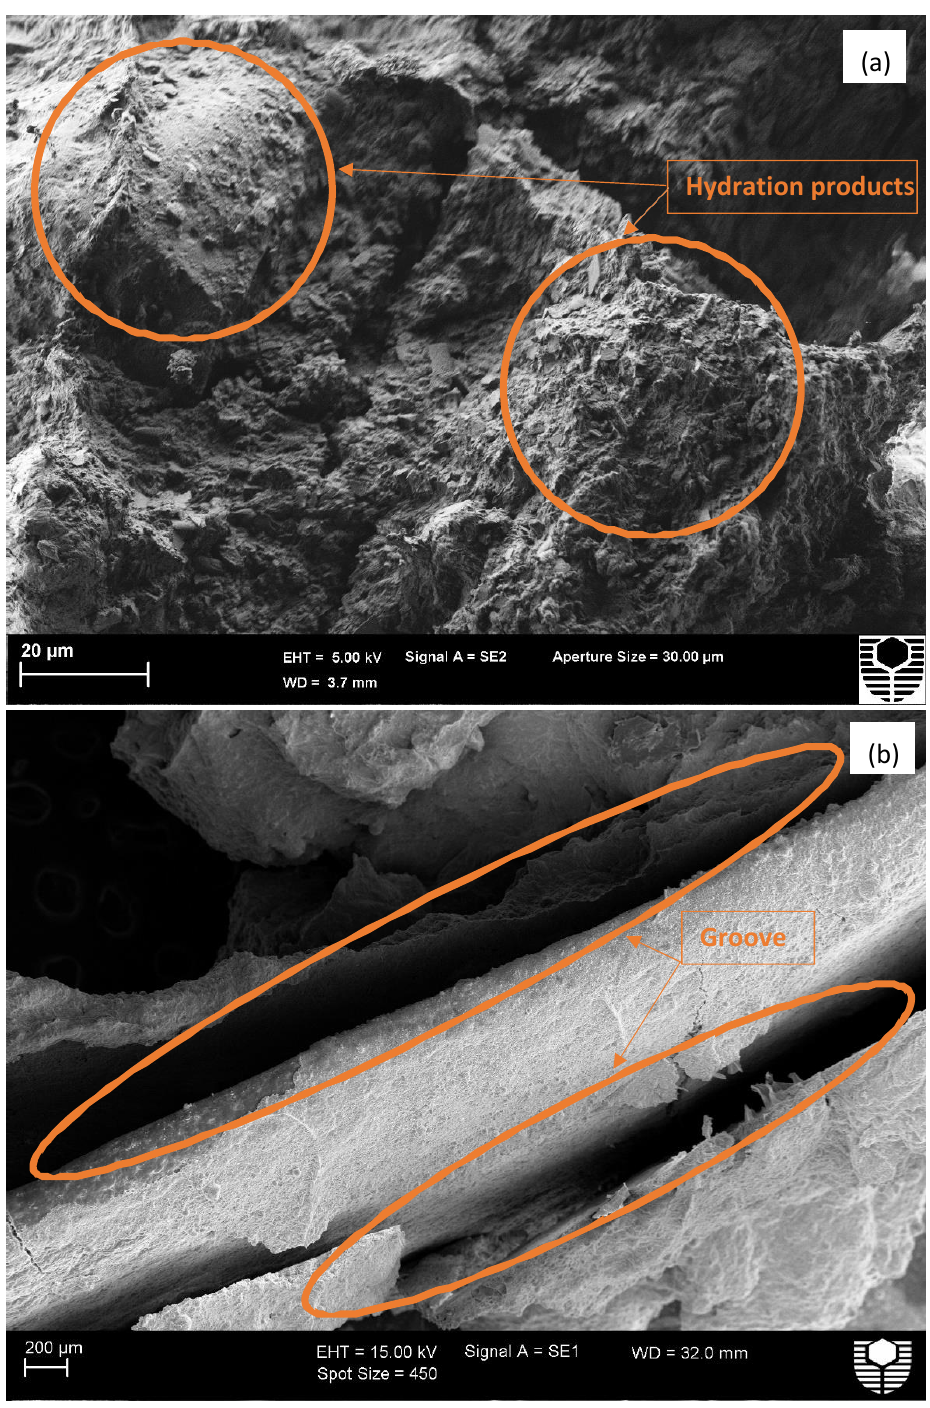
Figure 13. Scanning electron microscopic (SEM) analysis of the specimen 7PC-10SD: ( a ) before and ( b ) after sulphate attack.